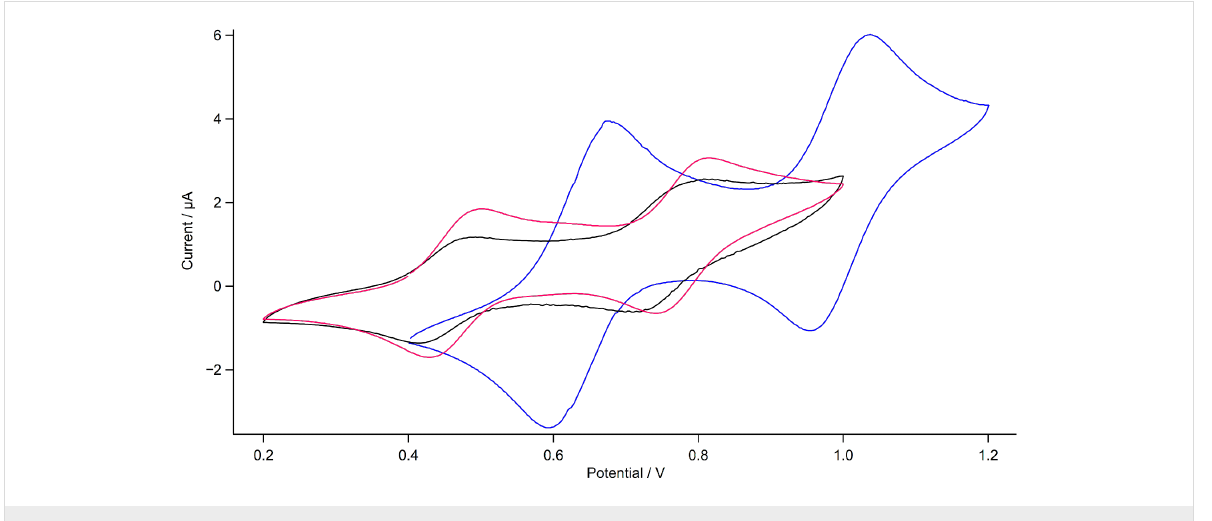
Figure 2: Cyclic voltammograms of 1 (blue line), 2 (red line) and 6 (black line) in CH 2 Cl 2 (0.1 M Bu 4 NPF 6 ; Pt working electrode; scan rate 100 mV s − 1 ).